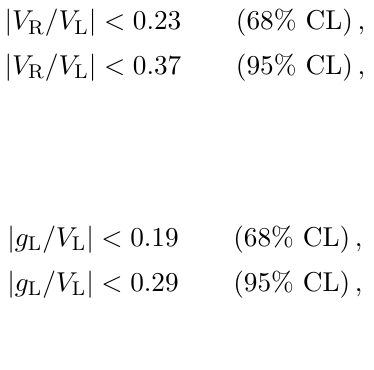
Figure 11. The likelihood pro(cid:12)les for the parameters (a) f 1 and (b) (cid:14) line indicates the evaluated likelihood in each bin of the pro(cid:12)led variable. The red dashed line represents the SM expectation. Additionally (c), the joint likelihood contour of (cid:14) of f 1 is shown. The red point represents the SM expectation while a black x mark indicates the observed value. The 68% and 95% CL regions are shown in green and yellow,